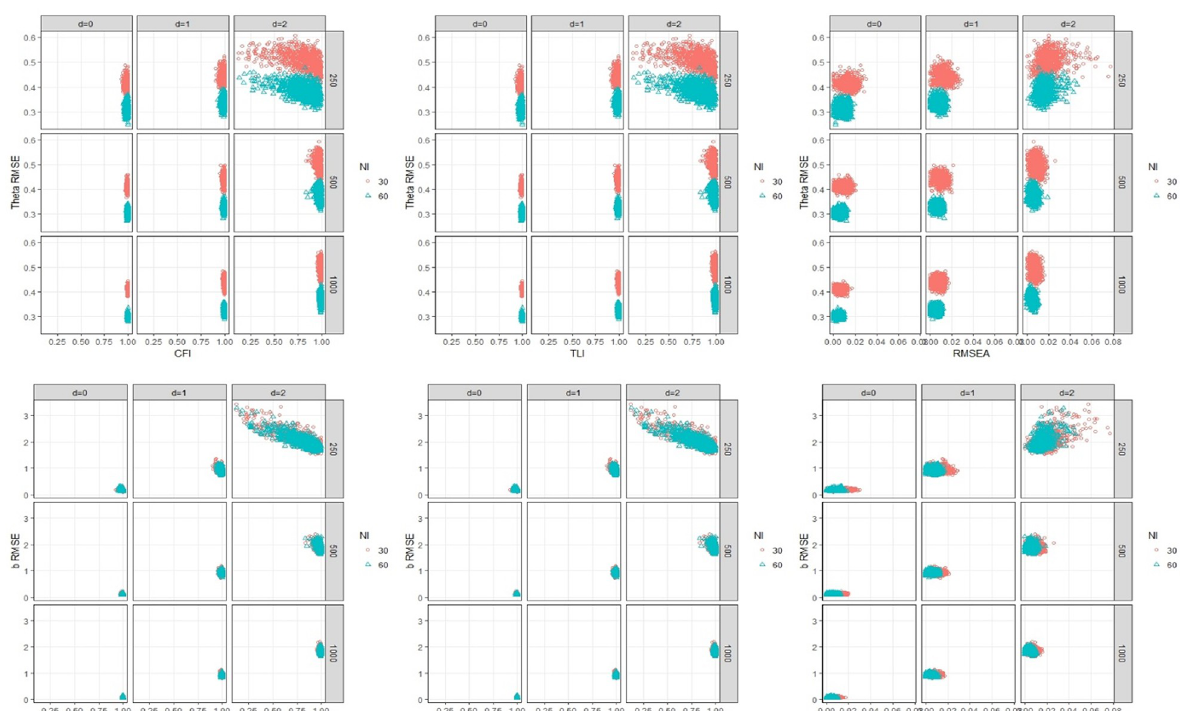
Fig 2. The relationship between WLSMV-based fit indices, theta RMSE/ ^ b RMSE, and test factors (RD) relationship between RMSEA and RMSE of ability and difficulty estimates with test factors.